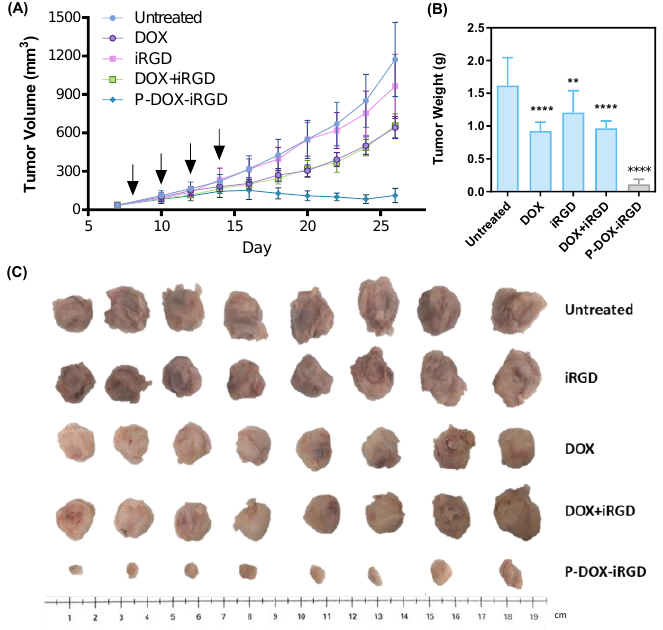
Figure 4. Anticancer activity of the polymer conjugate in an orthotopic 4T1 breast cancer model in BALB/c mice. ( A ) Tumor volume during treatment. ( B ) Primary tumor weight on day 26. ( C ) Primary tumor images on day 26. Data are shown as mean ± SD ( n = 8) ** p < 0.01, **** p < 0.0001. Arrows indicate the days of treatment injections (days 8, 10, 12, and 14) .